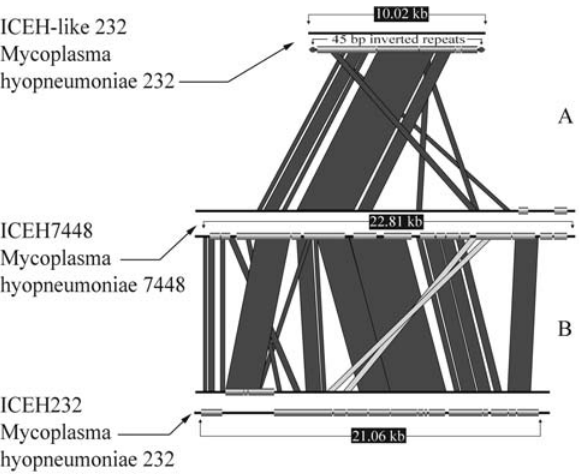
Figure 3 - TBLASTX (translated search of nucleotide sequences) similar- ity of the elements ICEH-like MH232, ICEH7448 and ICEH232. Dark gray bars denote direct sequence similarity between elements; light gray bars connect reverse sequence similarity between elements. CDS are rep- resented by boxes. Inverted repeats of the ICEH-like elements are repre- sented by arrows. The CDS represented are listed in Table 1 in order of appearance in the figure, except for the ICEH232 element that have the matches flipped for better visualization and the CDS are in inverted order as represented in the table. A: Comparison between the ICEH232-like ele- ment and ICEH232 element. B: Comparison between the ICEH232 ele- ment and ICEH7448